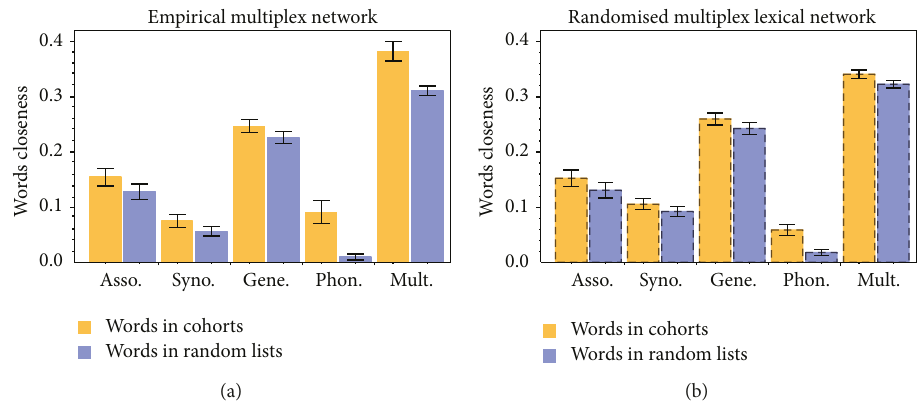
Figure 3: (a) Mean closeness distance of words either in cohorts or in randomised lists in the layers, respectively, made of free associations (Asso.), synonyms (Syno.), generalisations (Gene.), and phonological similarities (Phon.). (b) The same as in (a) but for randomised layers of word-word